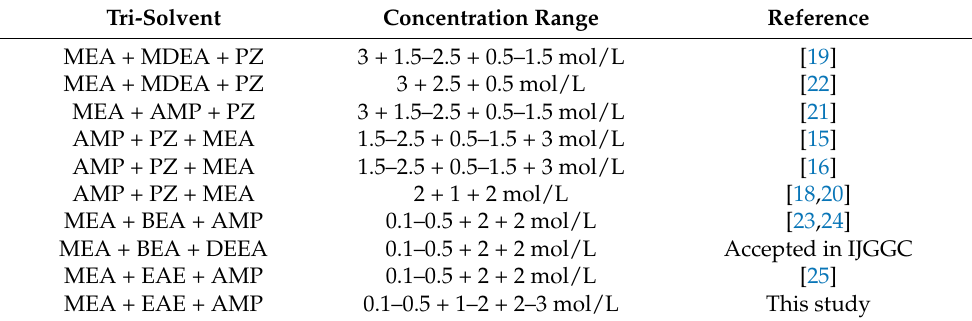
Table 1. Studies of various tri-solvents since 2016